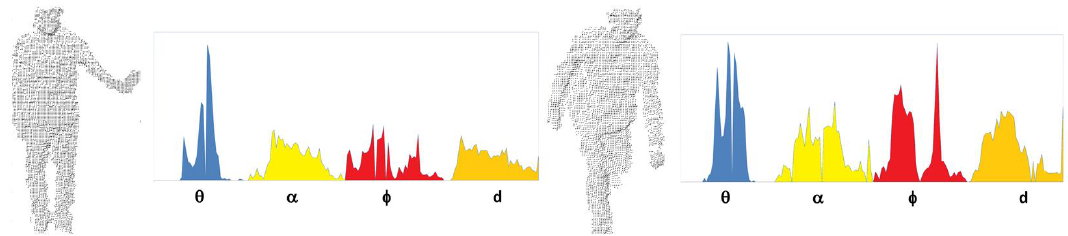
Figure 2. VFH histograms generated for point clouds representing two body